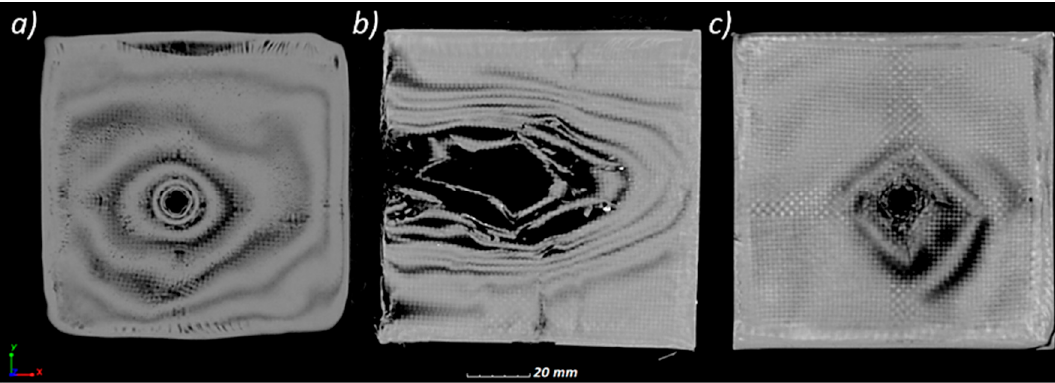
Figure 13. CT cross-sections through the composites after the tests: ( a ) PEHD_S, ( b ) PP_S, ( c ) PP_P. In all cases, delamination started from the impact point and propagated throughout the panels.